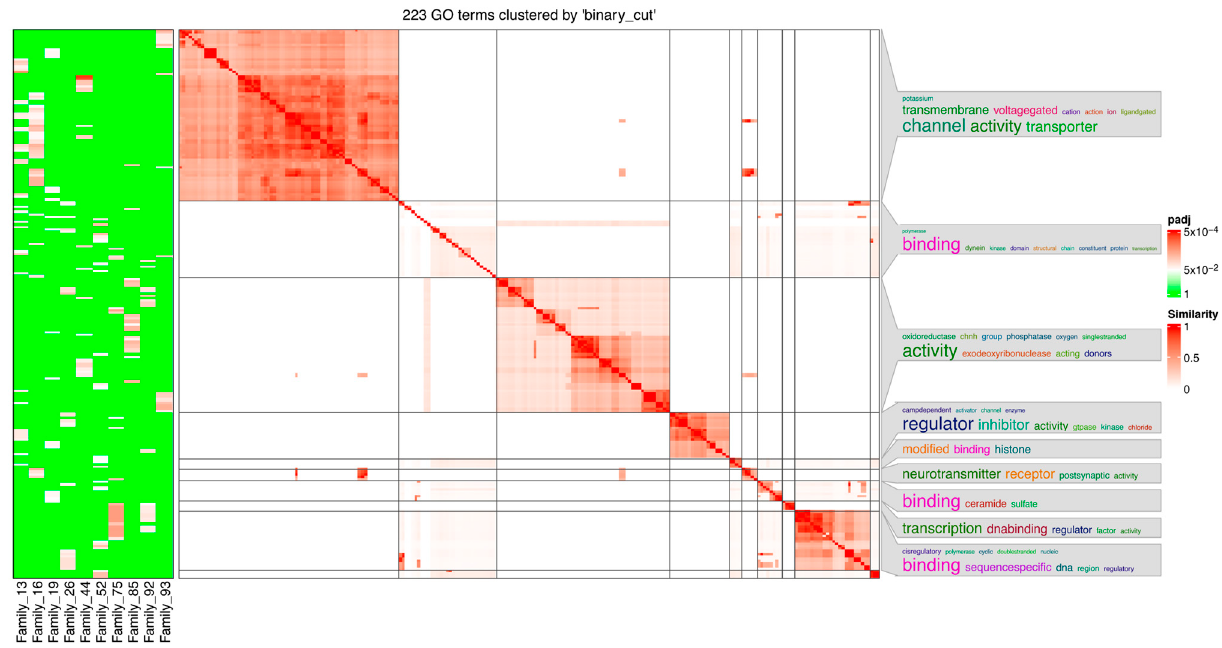
Figure 7. Summary of enriched GO terms for select families as determined by the GOProfiler and simplifyEnrichment R packages. simplifyEnrichment R